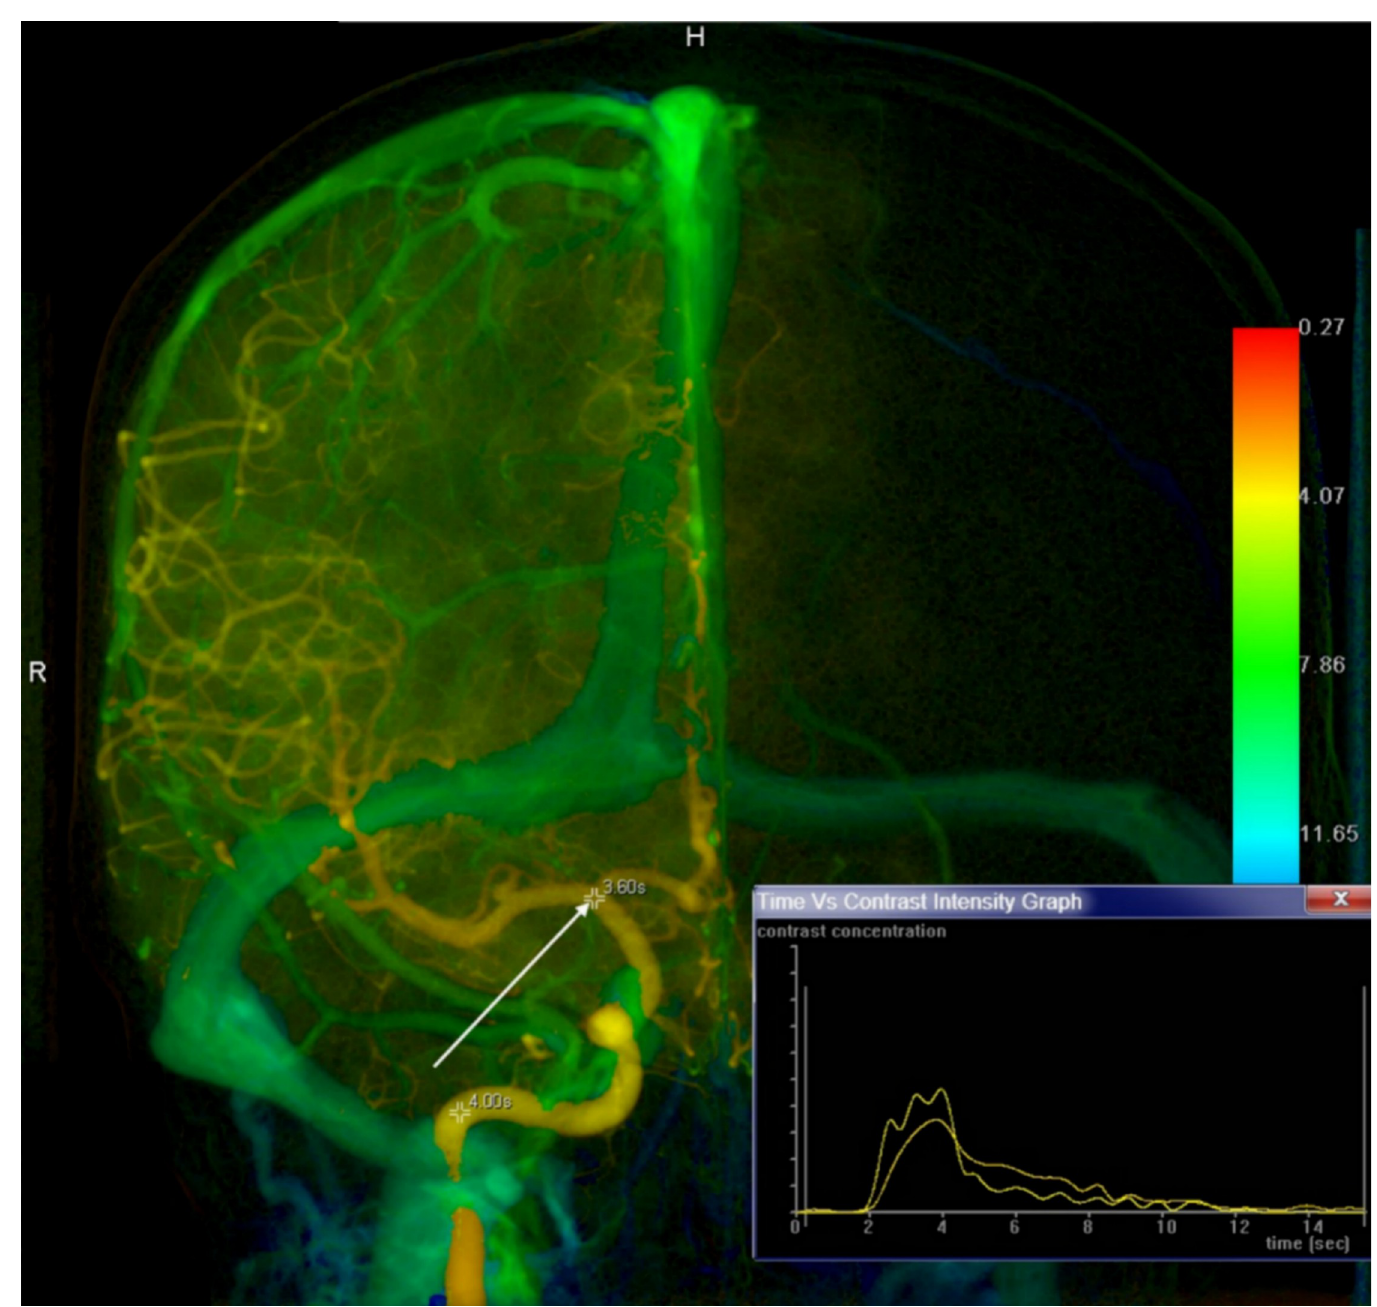
Fig 2. Display of the region-of-interest in color-coded digital subtraction via the anteroposterior (AP) view. The contrast concentration was measured at the terminal internal carotid artery ( white arrow ) in the AP